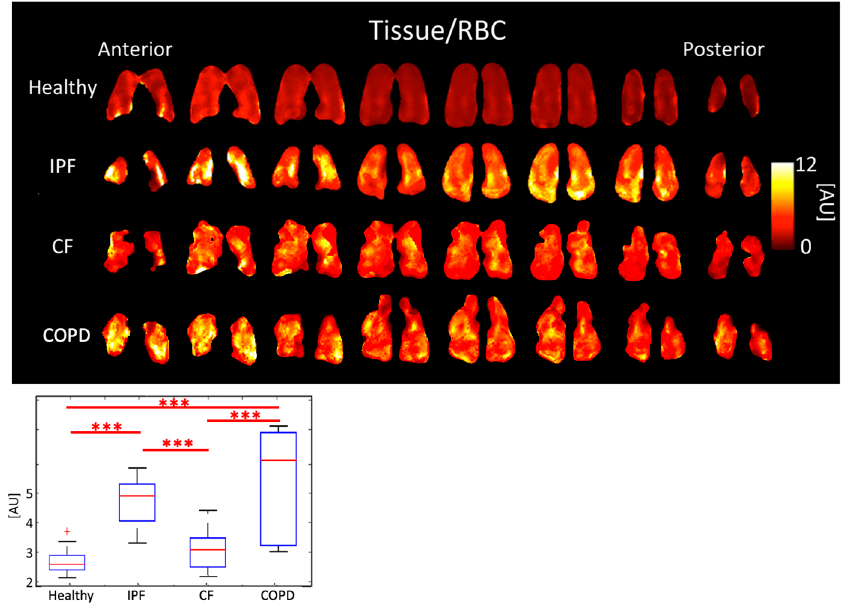
Figure 3. Tissue/RBC ratio maps ( top ) and boxplots ( bottom ) for each disease type. ( p < 0.001 = ***, + + outlier) .